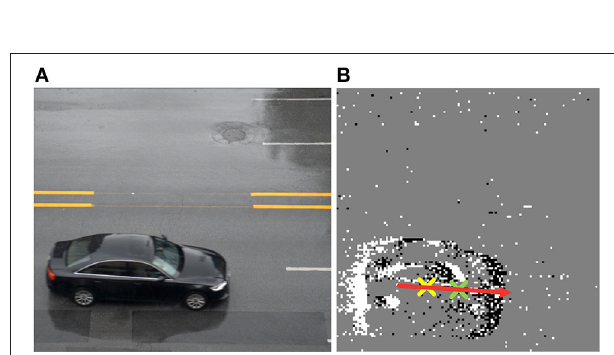
FIGURE 11 | The orientation detection of moving vehicle collected by DVS in real time. (A) Picture taken with a frame-driven camera. (B) Snapshot mapping by AER events and the arrow shows the orientation of a moving